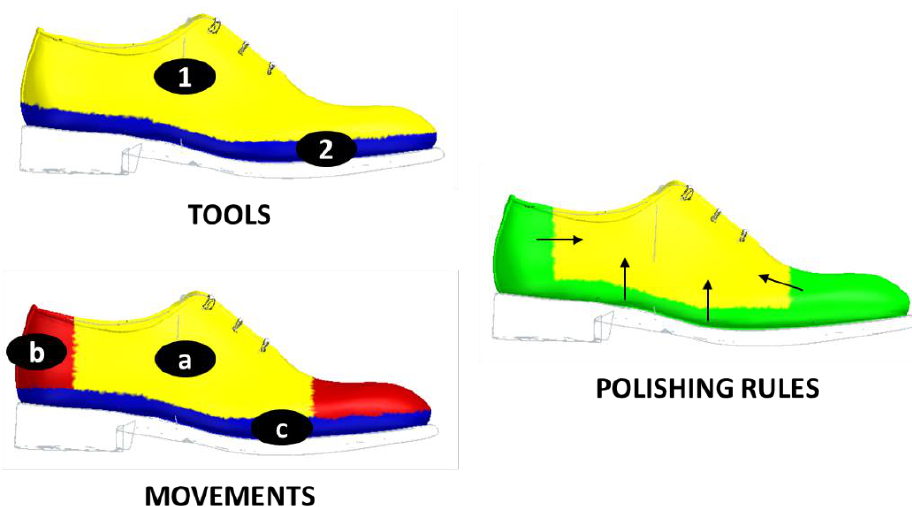
Figure 2. Subdivision of the shoe into areas based on tools, movements, and polishing rules.